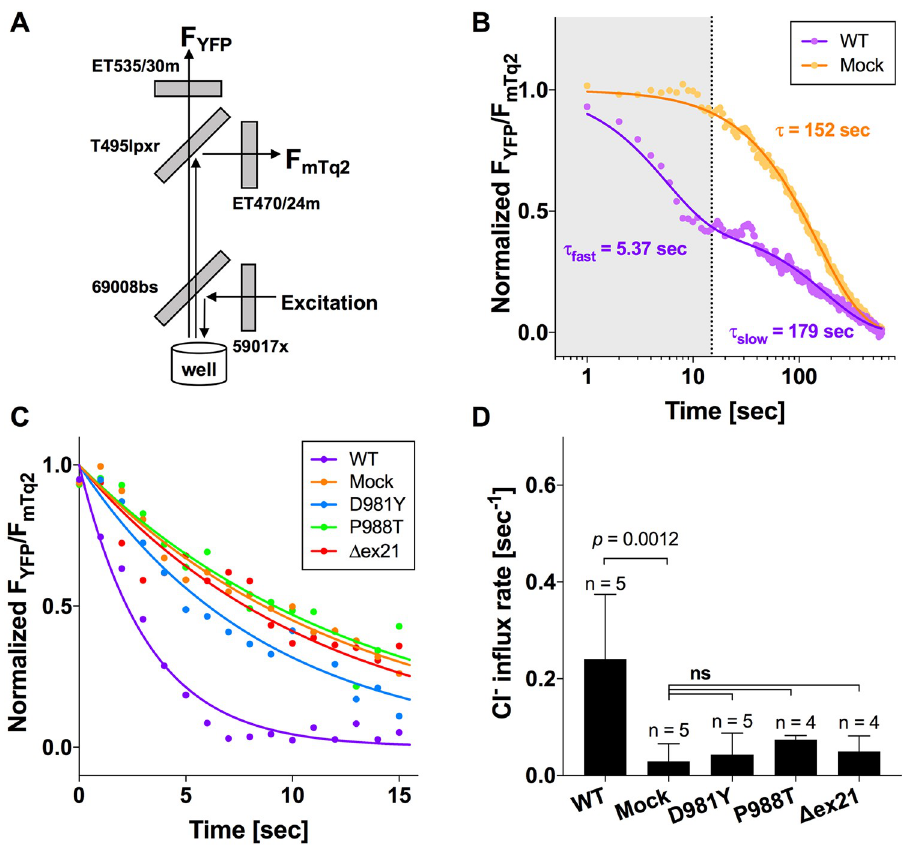
Fig 4. Cl − influx assay of the recSLC12A2 constructs in vitro . (A) Schematic representation of the optical configuration used for simultaneous measurements of YFP and mTurquoise2 (mTq2) fluorescence (F YFP and F mTq2 ), showing band-pass filters and dichroic mirrors. (B) Cl − influx measured in WT recSLC12A2- (purple) and empty vector-derived YFP (mock, orange)-expressing cells. Solid lines indicate single (for mock) and double (for WT recSLC12A2) exponential curve fitting. A 15 sec time window (area shaded in gray) was used to calculate recSLC12A2-mediated Cl − influx. (C) Representative recordings from cells expressing each recSLC12A2 variant are shown in the respective colors. Solid lines indicate single exponential curve fits from which Cl − influx rates were calculated. (D) Summary of the Cl − influx assay. One-way ANOVA and Tukey-Kramer multiple comparison tests were performed to calculate the adjusted p values. Error bars represent SD. ns, not significant ( p � 0.05); Δ ex21, exon 21-encoded region truncated isoform.